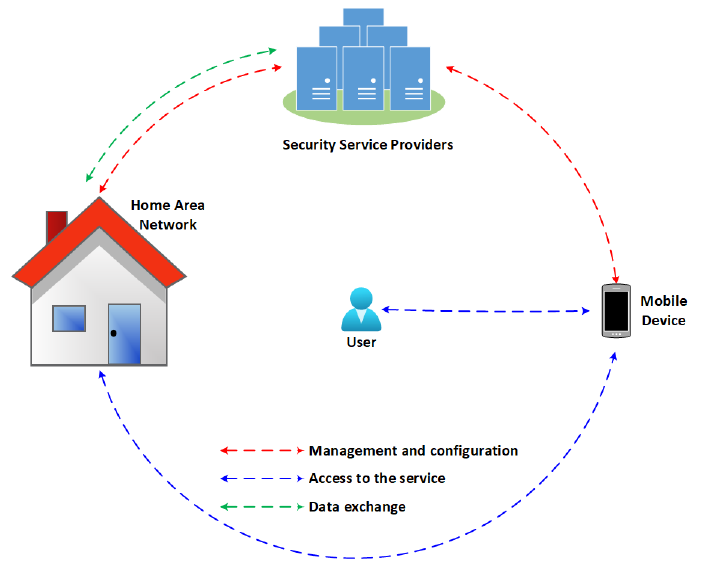
Figure 1. High level architecture. The user can access some of the security services provided by SSPs using mobile devices.